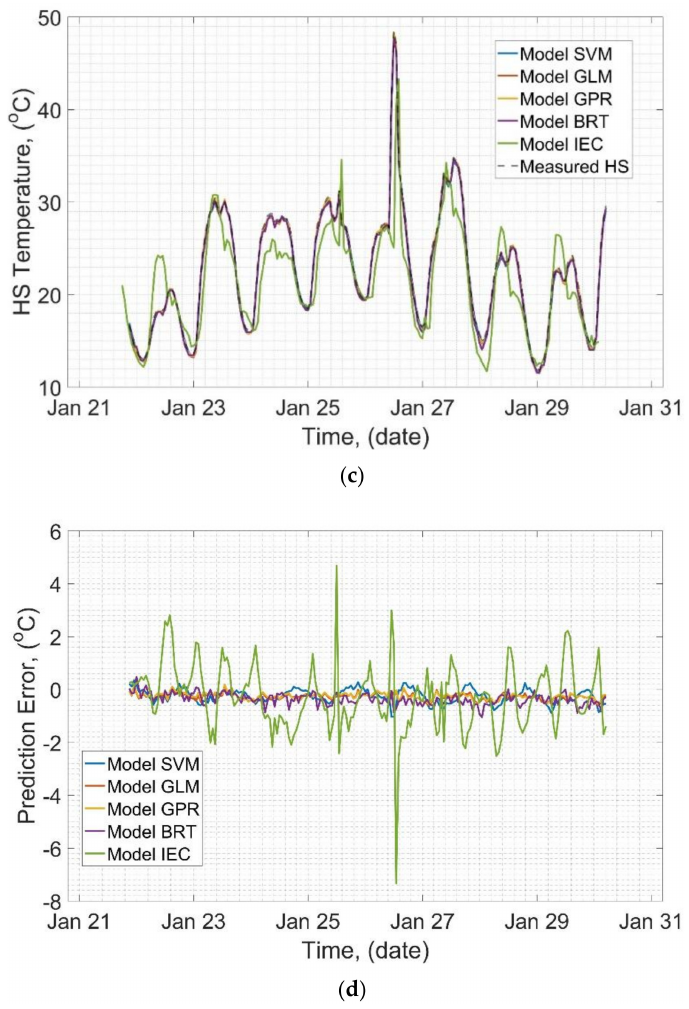
Figure 7. Exemplary results of HS modeling in Tr1 for all models. Winter: ( a ) temperature runs of HV winding, ( b ) errors of models for HV winding, ( c ) temperature runs of LV winding, ( d ) errors of models for LV